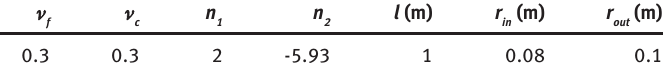
Figure 3 The convergence behavior of maximum (A) U * and (B)